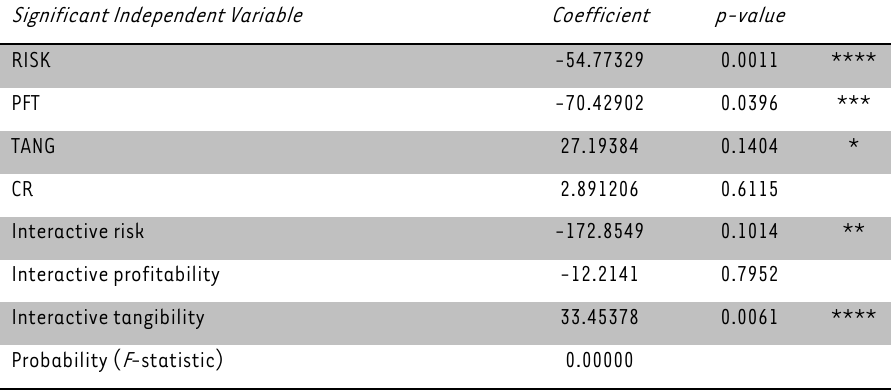
TABLE 7: Random effects model results of the impact of the 2008 financial crisis on the significant company-specific capital structure